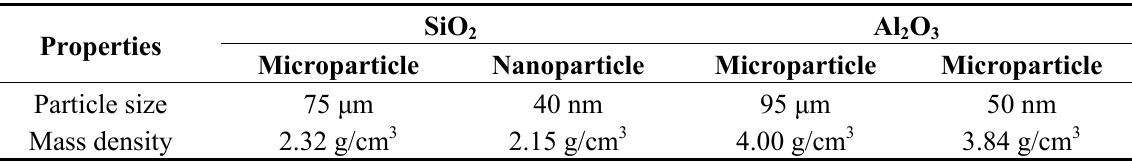
Table 2. Particle size and mass density of activated oxides used in this study.